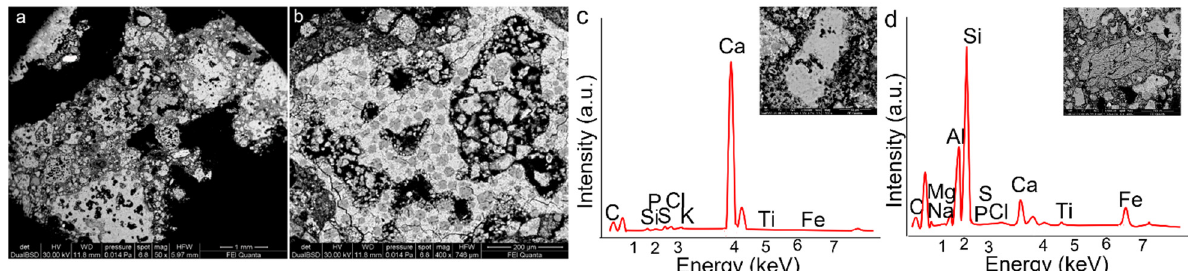
Figure 11. SEM images ( a – d ) of the sample M3 showing fragments of red pozzolan rich in analicimized leucite ( b ). In ( c , d ) details of the carbonate and clay minerals lumps are reported EDS with the respective EDS spectra.